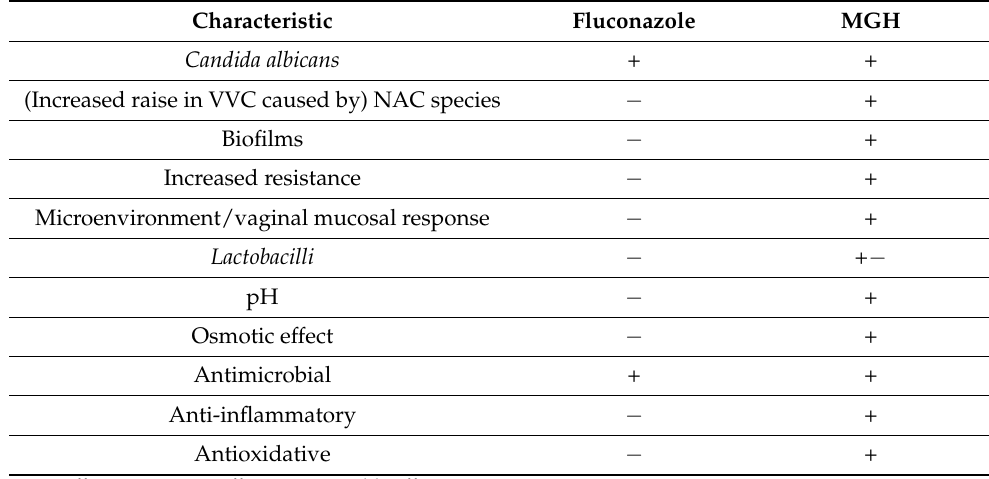
Table 1. Overview antipathogenic activity of fluconazole and